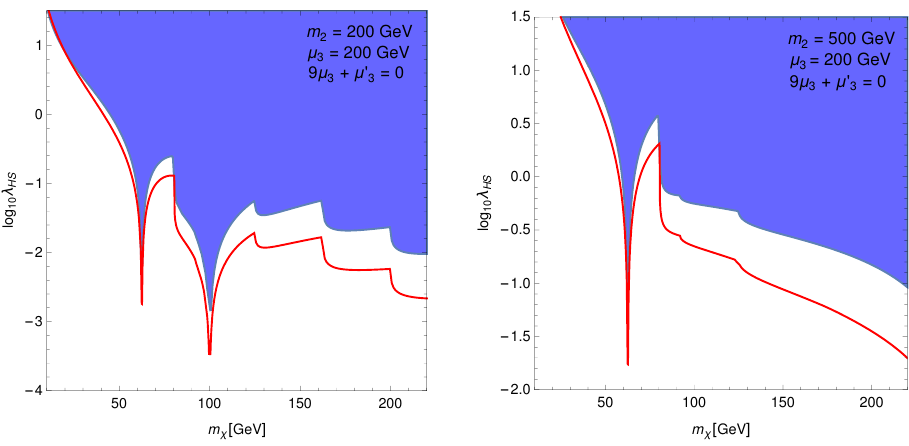
Figure 5 . The left panel presents the indirect-detection constraints for m 2 = 200 GeV and the right panel for m 2 = 500 GeV. In both panels sin (cid:18) = 0 : 2. The red curve shows where the model reproduces the observed relic density, f rel = 1. The blue area is excluded by the latest